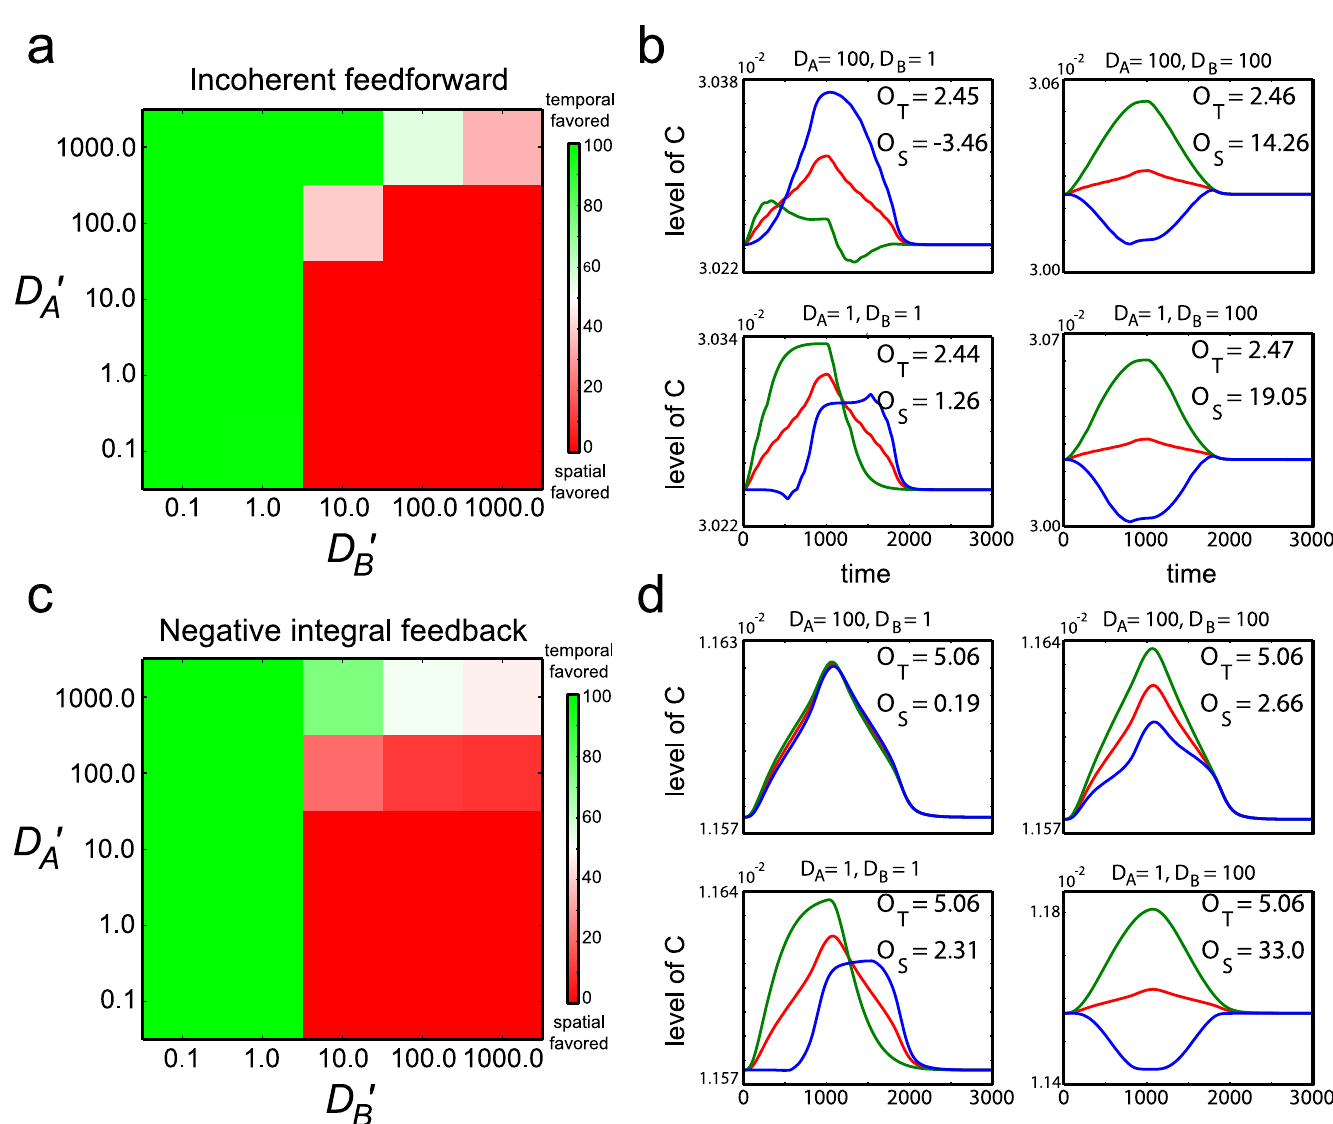
Fig 4. Temporal sensing is favored over spatial sensing when diffusion rate of activator is higher than that of the inactivator. (a,c) Fraction of parameters that choose temporal sensing over spatial sensing for different values of D 0 (c). (b,d) Dynamics of the average level of protein C (red), level of protein C at the front (green) and back (blue) for different values of D 0 feedforward (b) and negative integral feedback circuits (d). O